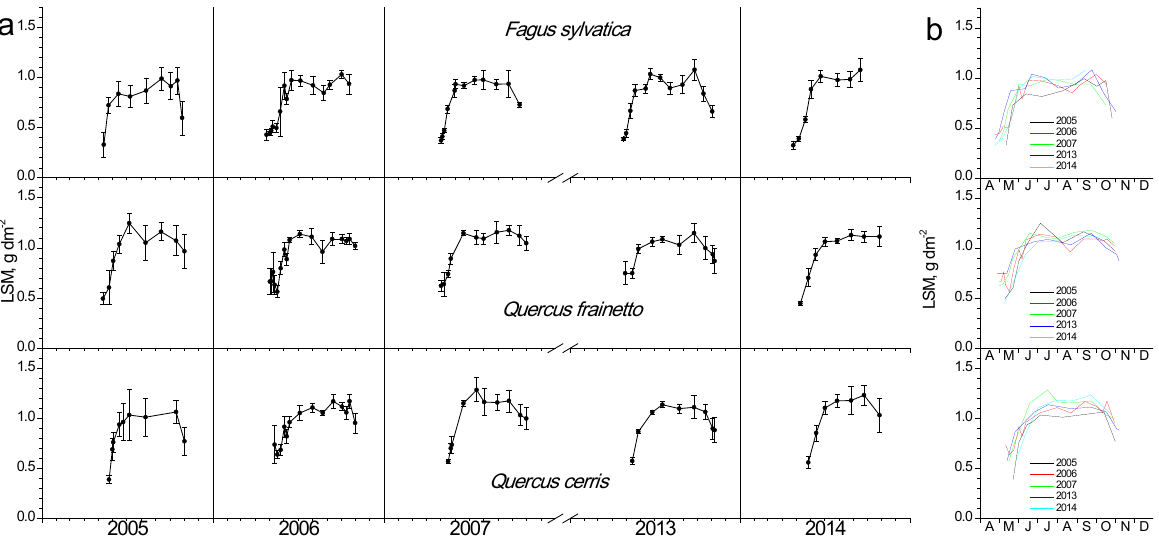
species and years have been observed. The only noteworthy is a trend for increased values in Q. cerris in the dry 2007.